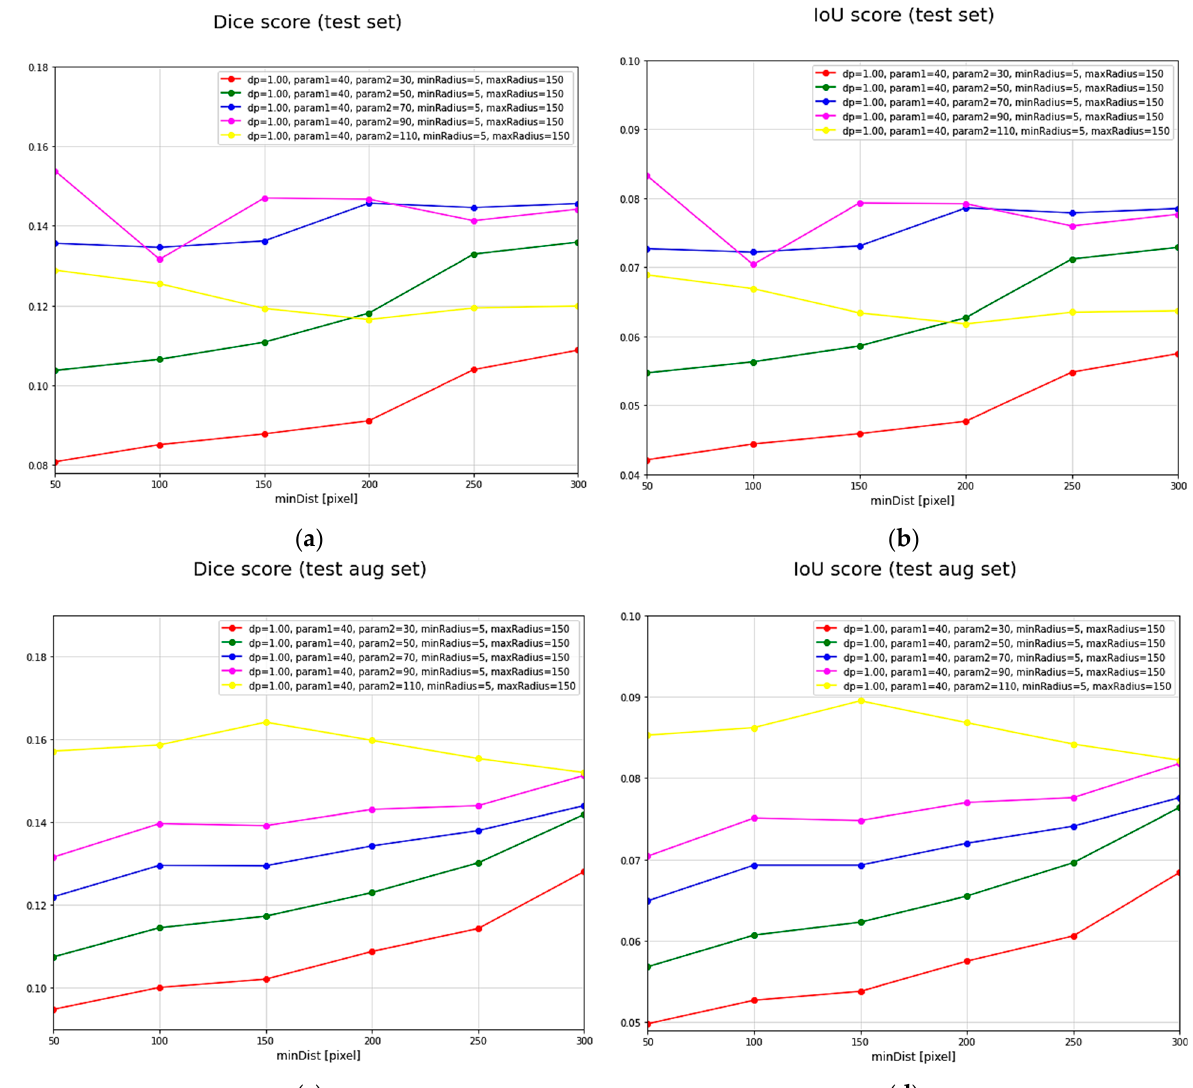
Figure 9. Comparison of DICE and IoU evaluation scores on TEST and TEST AUG sets for different Hough transform parameters’ combinations: ( a ) DICE score for test set, ( b ) IoU score for test set, ( c ) DICE score for augmented test set, and ( d ) IoU score for augmented test set.